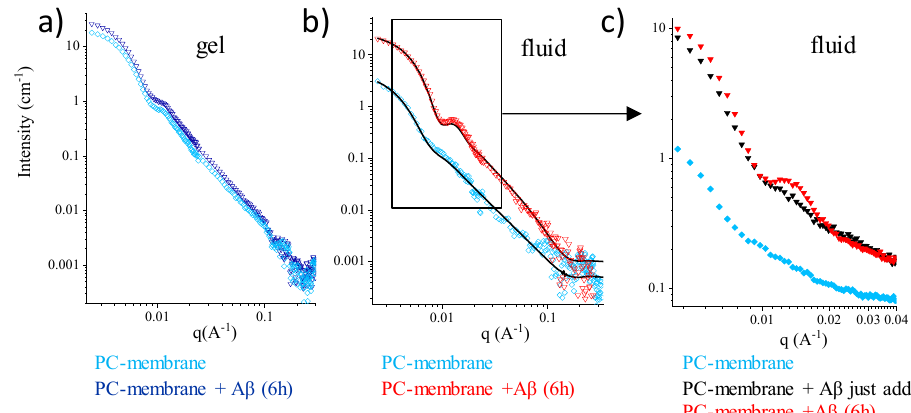
Figure 1. Phosphatidylcholine (PC)-phospholipid bilayers upon interaction with A β mon (small-angle neutron scattering (SANS)). ( a ) T = 25 ◦ C (gel). Spectra of Dipalmitoyl phosphatydilcholine (DPPC d75 ) unilamellar vesicles in D 2 O (c = 15 mg / mL) before (cyan open diamonds) and after 6 h of incubation with A β mon(1–40) (blue triangles). ( b ) T = 50 ◦ C (fluid). Spectra of DPPC d75 unilamellar vesicles in D 2 O before (cyan open diamonds) and after 6 h of incubation with A β mon(1–40) (red triangles). DPPC d75 scattered intensity is very low above the chain melting temperature (Tm = 39 ◦ C), as the system is close to the contrast-matching condition. Lines are the fitting curves. ( c ) T = 50 ◦ C (fluid). Focus on the restricted area enclosed in the rectangle of panel ( b ) added with the spectrum of the DPPC d75 unilamellar vesicles in D 2 O just after injection of the solution containing A β mon(1–40) .